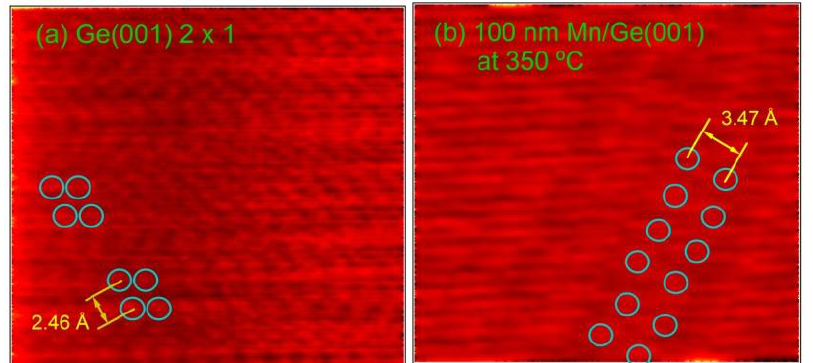
Figure 2. Scanning tunneling microscopy (STM) images obtained at a tip voltage of +150 mV (empty-states images), on ( a ) clean Ge(001) and ( b ) after the deposition of 100 nm Mn at 350 °C. The scanned area is 3 ×3 nm 2 in both